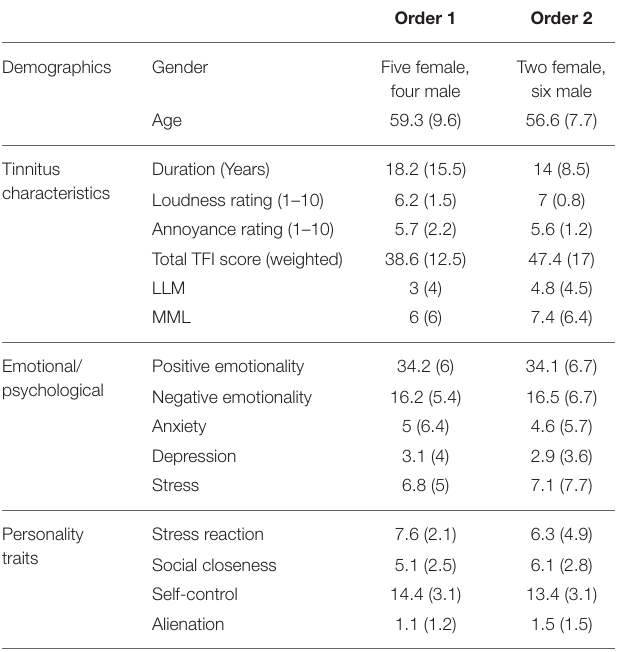
TABLE 2 | Average baseline characteristics of participants as measured at the start of the